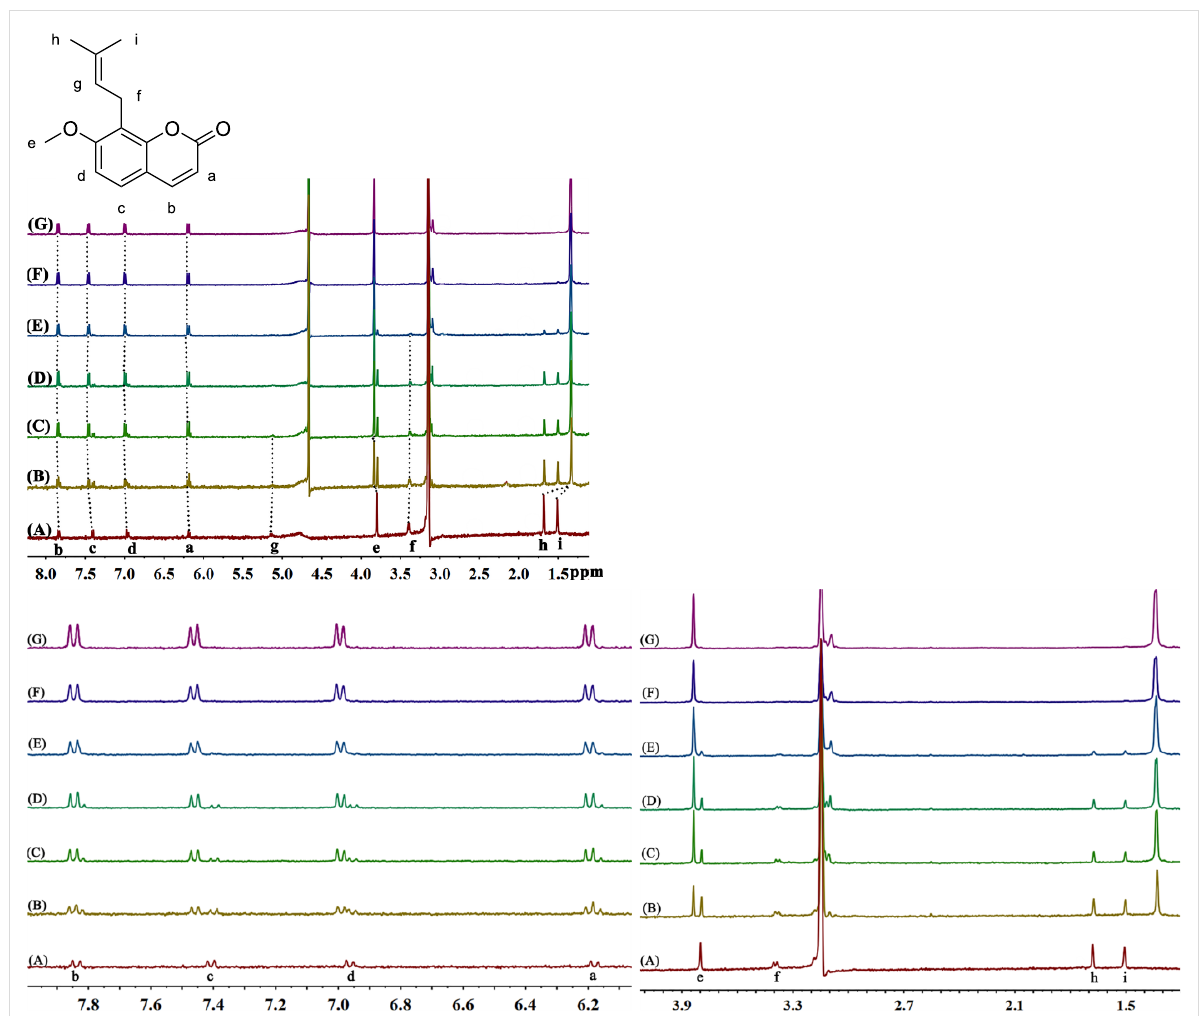
Figure 6: 1 H NMR titration spectra recorded for OST ( c = 5 × 10 − 4 mol ∙ L − 1 ) during the addition of different molar equivalents of Hg 2+ (400 MHz, D 2 O, n (Hg 2+ )/ n (OST) = 0 (A), 0.2 (B), 0.4 (C), 0.8 (D, E), 1.0 (F), 1.2 (G), pH 7.0, D 2 O/CH 3 OH 97:3, v/v).